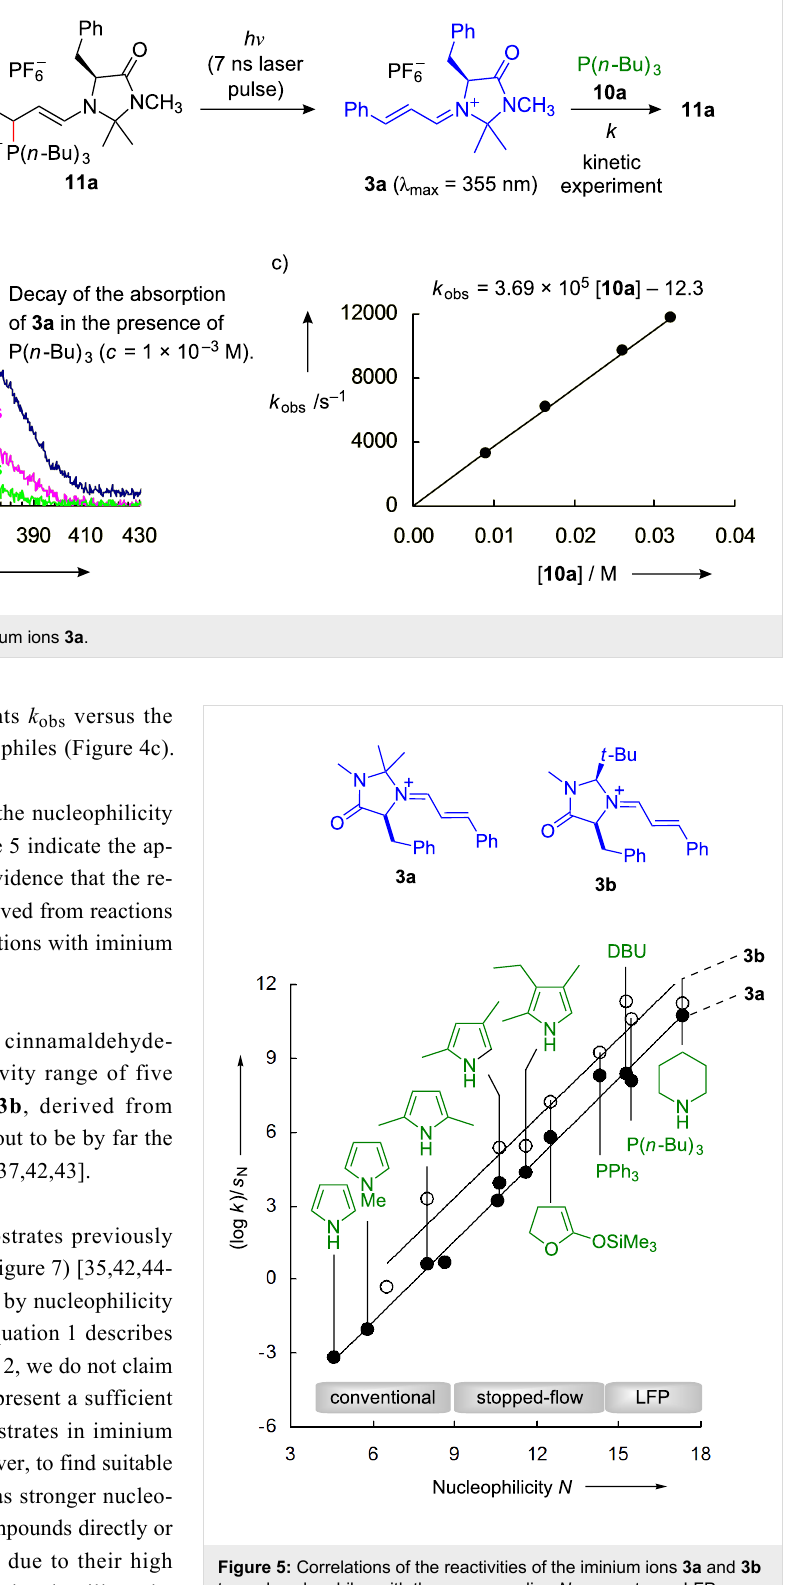
Figure 5: Correlations of the reactivities of the iminium ions 3a and 3b toward nucleophiles with the corresponding N parameters – LFP = laser flash